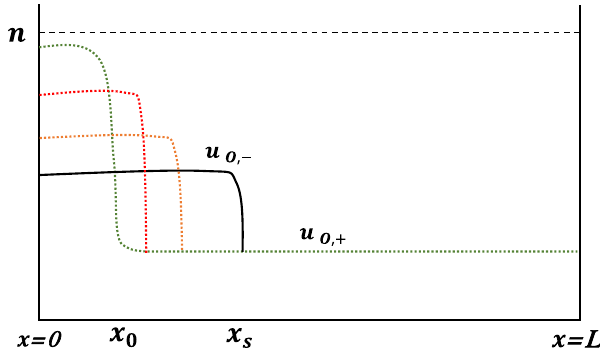
FIG. 12. The schematic plot for the oxygen shock-wave front propagation. The green curve is the initial distribution where oxygen is piled up at x < x 0